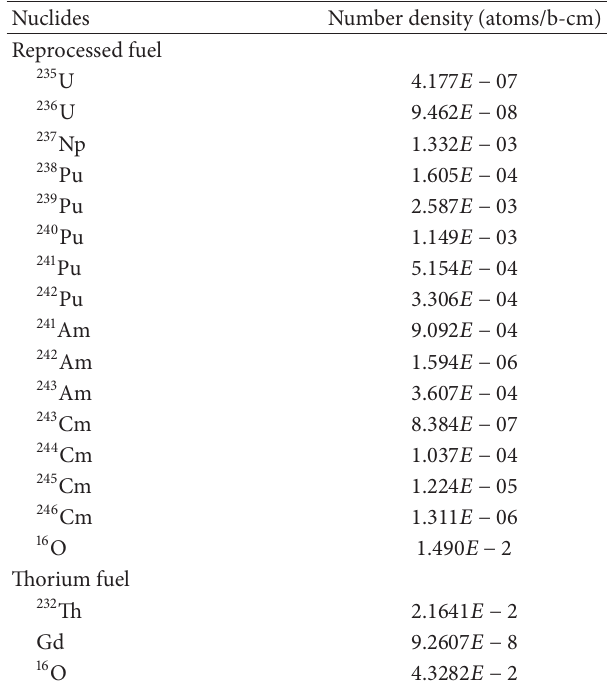
Table 1: Fuel composition of thorium and reprocessed